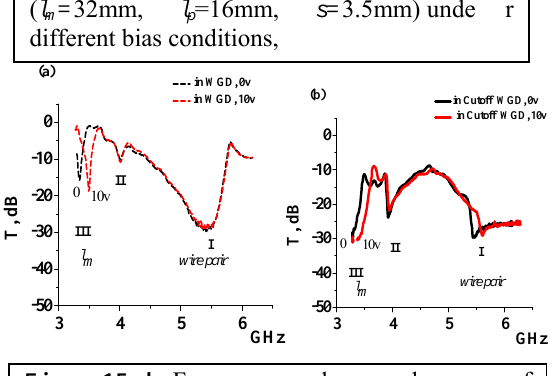
Fig . 14. Frequency dependences of transmission T in the WG (dashed) and cutoff WG (solid) in the presence of m etastructure “ Grating - varactor lo aded split l ongitudinal cu t-wire l m ” different bias conditions,